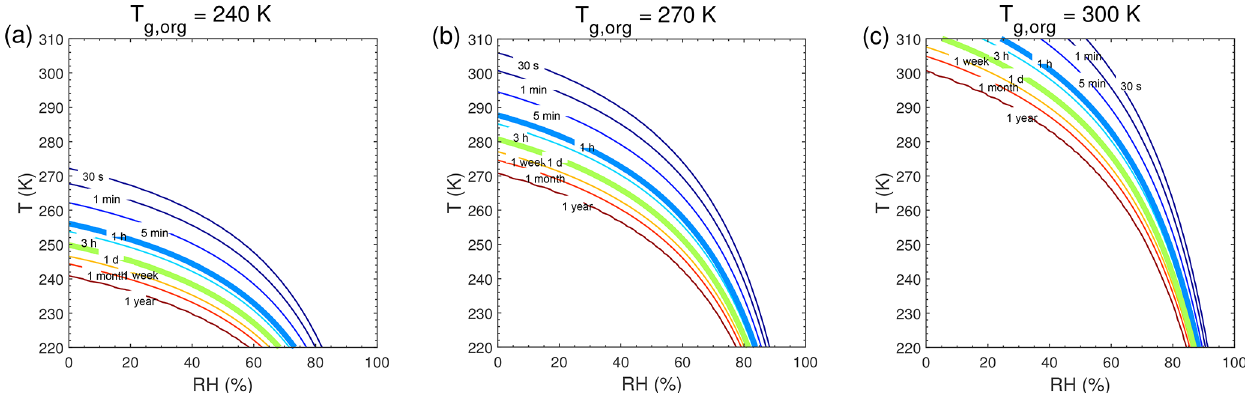
Figure 5. Equilibration timescale ( τ eq ) as a function of temperature and relative humidity in the closed system. The glass transition tem- peratures of preexisting particles at dry conditions ( T g , org ) are (a) 240K, (b) 270K, and (c) 300K. The saturation mass concentration ( C 0 ) of the condensing compound is 10µgm − 3 (SVOC). The mass concentration of preexisting particles is set to 20µgm − 3 with the number concentrations of 3 × 10 4 cm − 3 and the initial particle diameter of